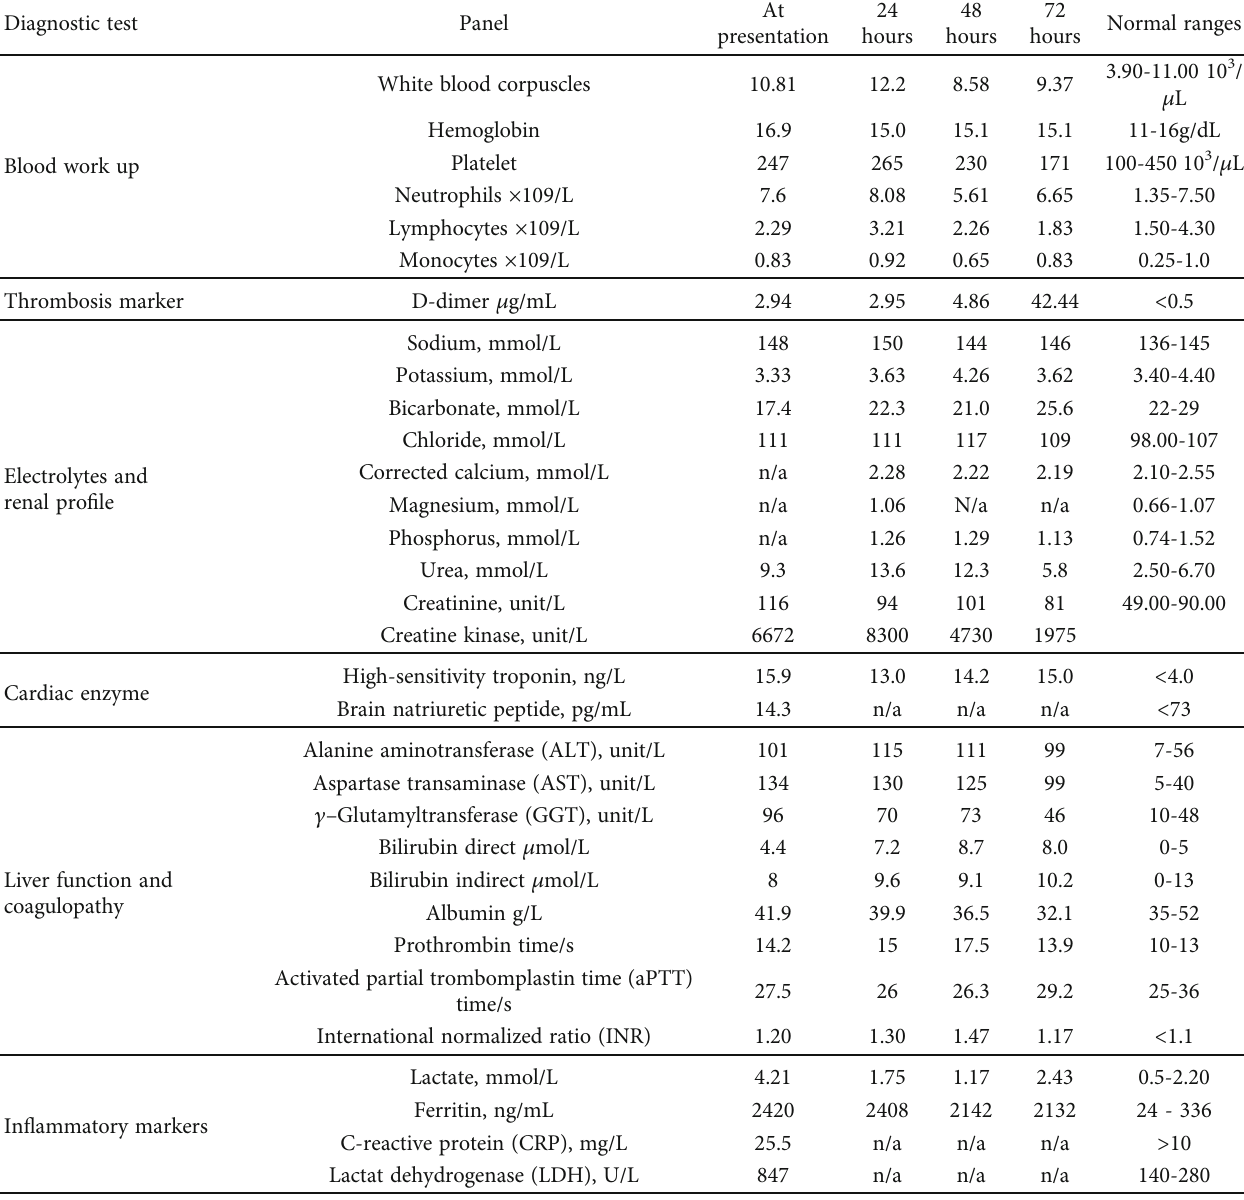
Table 1: Diagnostic results throughout the course of